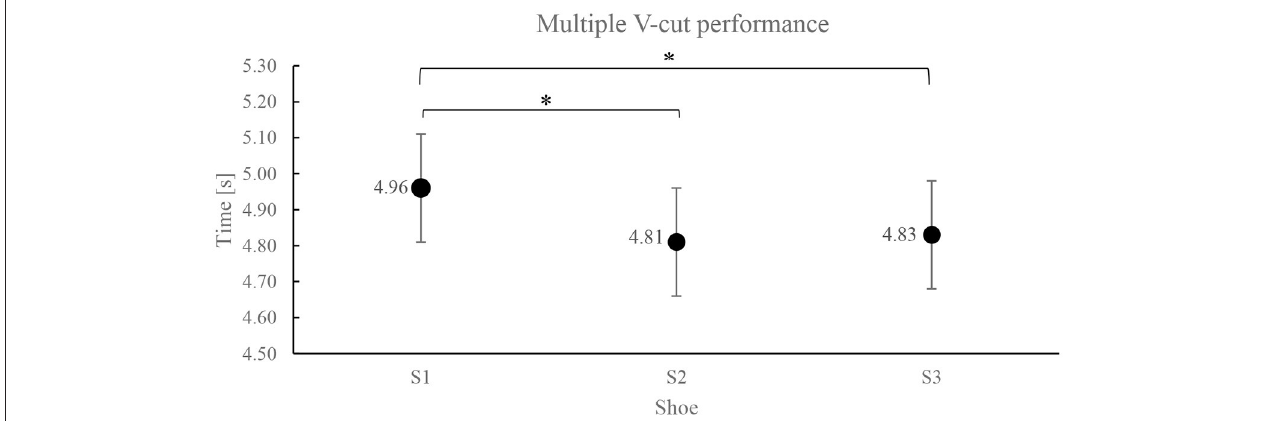
FIGURE 2 | Mean value ( ± SD) of multiple V-cut performance (*ANOVA: p <